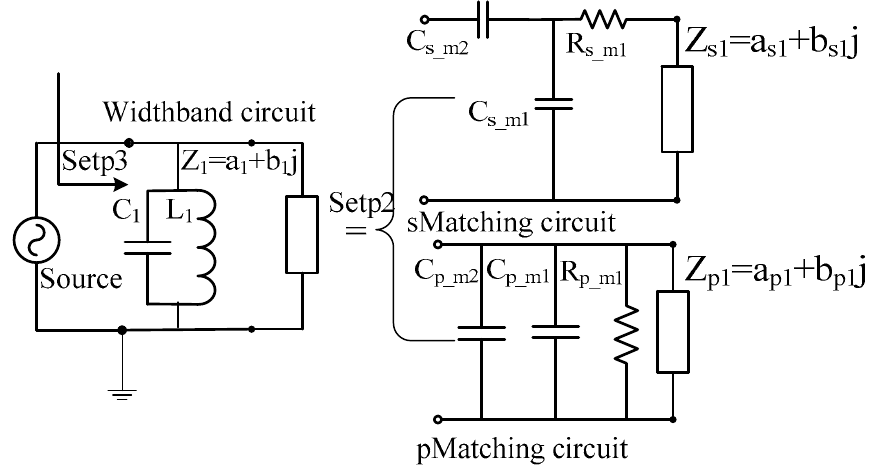
Figure 5. An LC resonator for the second-step electronic circuit. Several pairs of specific parameters of the LC resonator meeting the restriction of Equation (3) are listed in Table 2. After fine adjustment, the final data are determined by plotting the performance of the electronic elements on a Smith